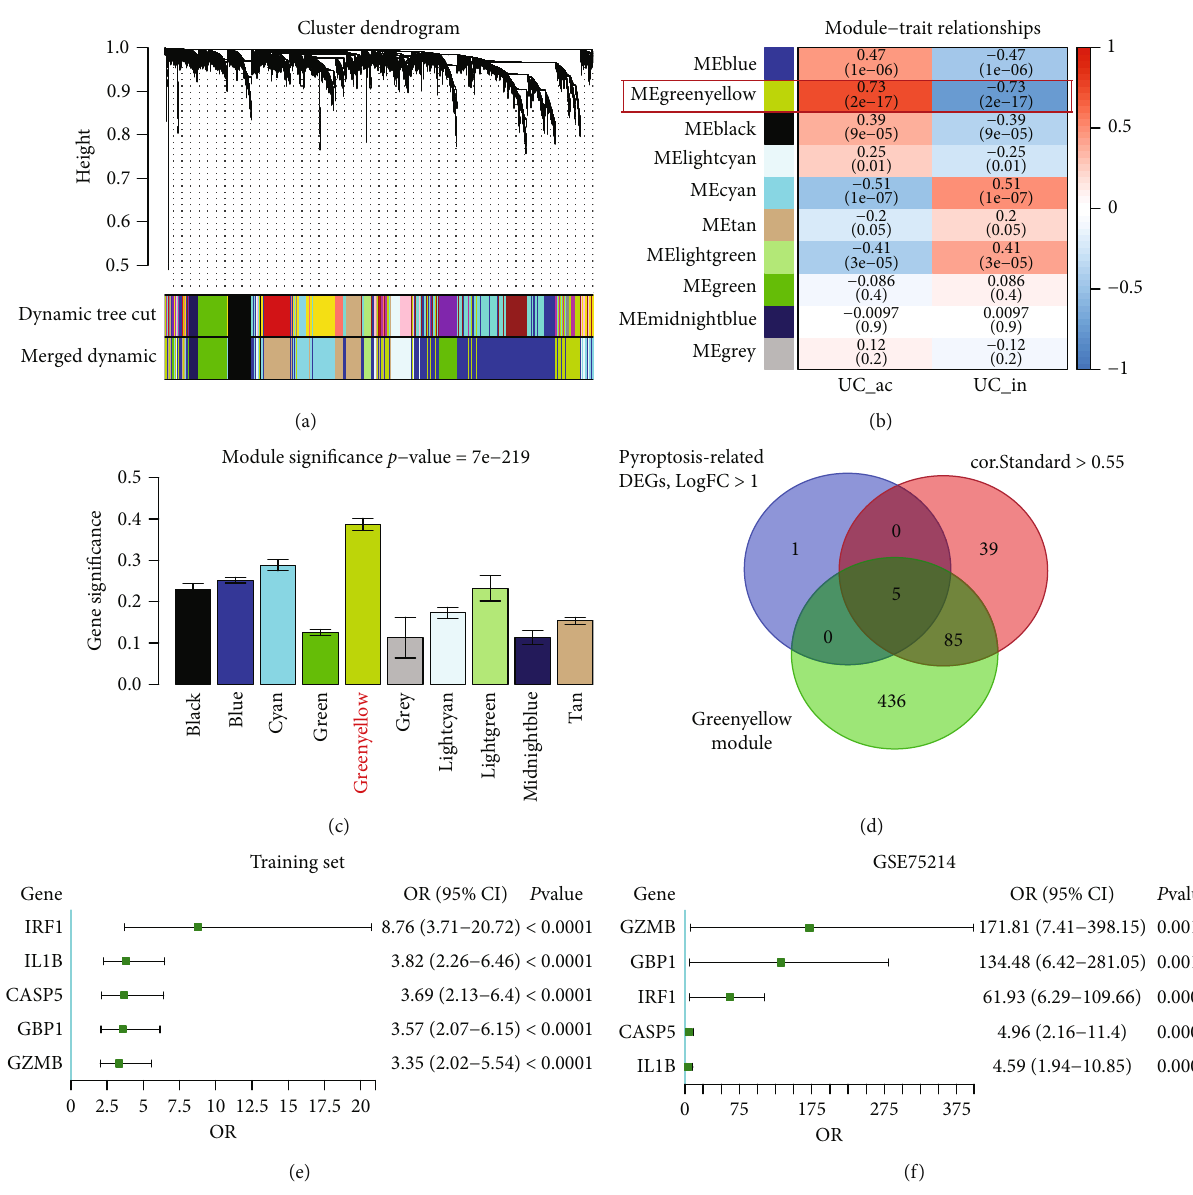
Figure 3: Identify the key PRGs and establish the PR-Score. (a) Module clustering dendrogram based on a dissimilarity measure (1-TOM). (b) Heat map of the correlations between MEs and active/inactive UC. (c) Distributions of average gene signi fi cance and errors in the modules related to active ulcerative colitis. (d) Venn diagram showed the overlapping genes between di ff erentially expressed PRGs, the genes of greenyellow module, and the genes with ∣ cor : Standard ∣ >o : 55 in WGCNA. Logistic regression analysis for the key PRGs in the training set (e) and GSE75214 (f). ME: module eigengene; UC: ulcerative colitis; ac: active; in: inactive; DEGs: di ff erentially expressed genes; OR: odds